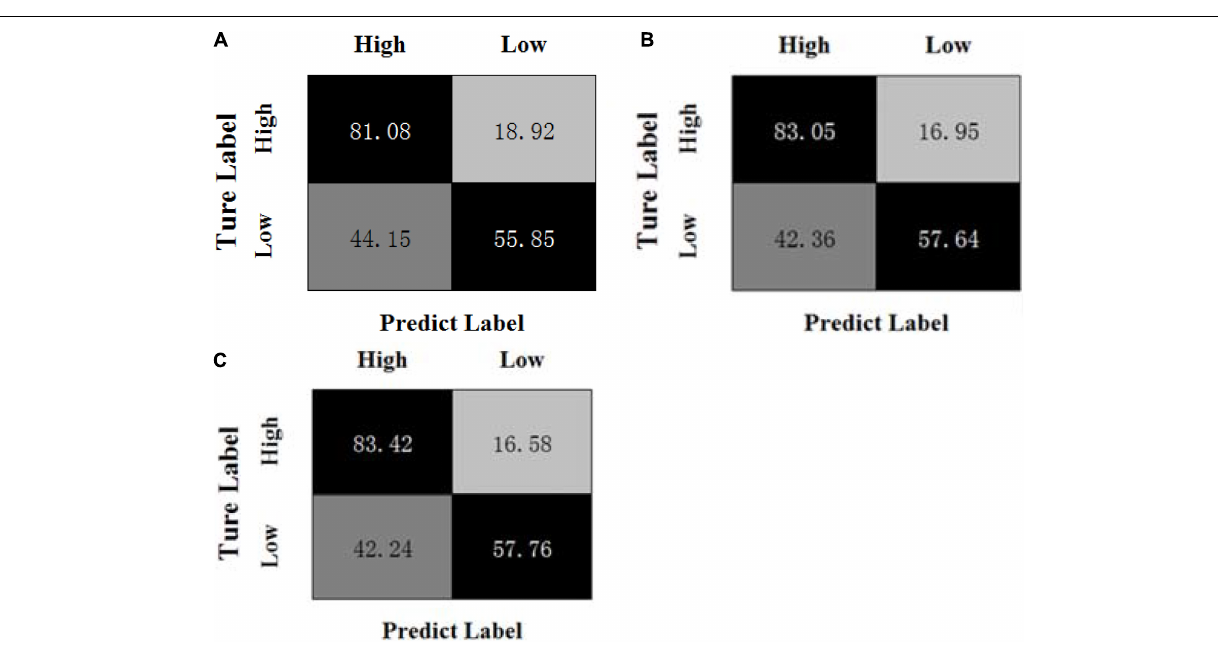
FIGURE 6 | Confusion matrices of MBCC on the DEAP dataset in arousal, (A) β + γ , (B) α + β + γ , (C) θ + α + β + γ